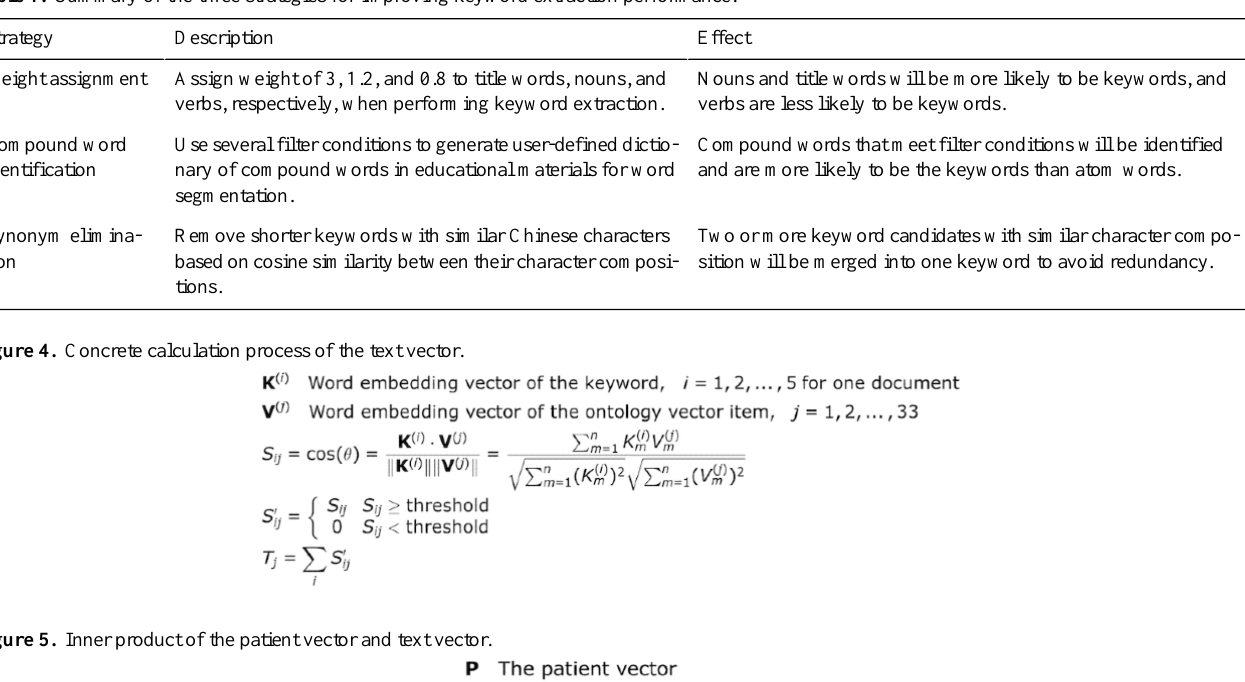
Table 1. Summary of the three strategies for improving keyword extraction performance.